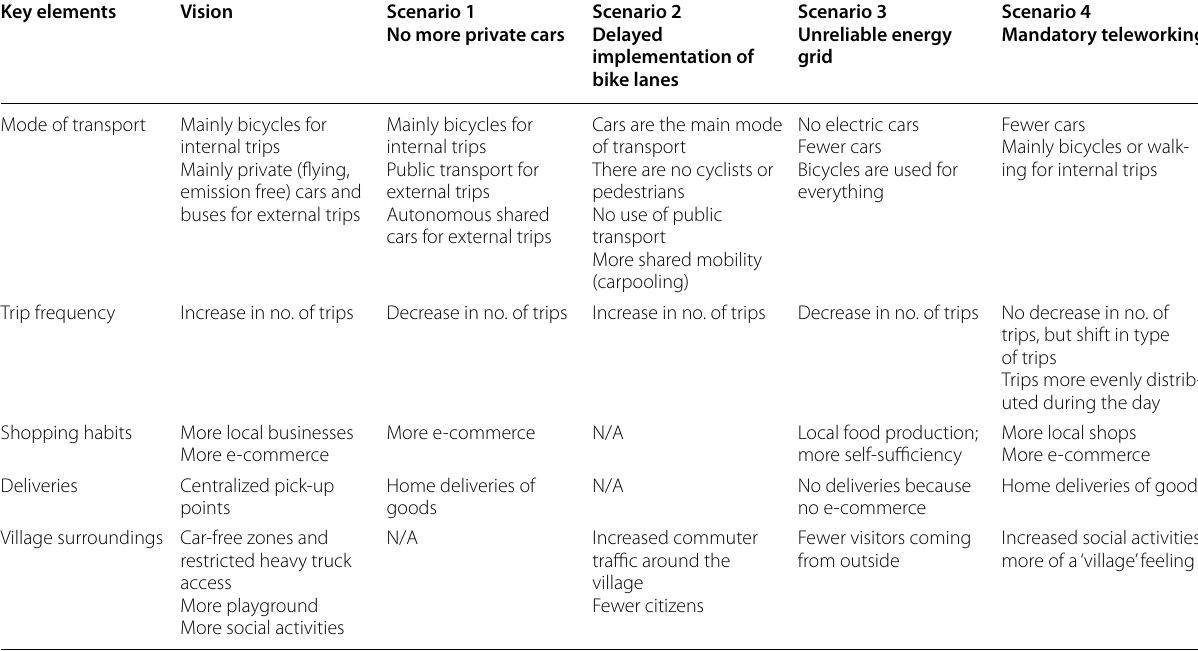
Table 3 Comparison of visions and scenarios per key element Key